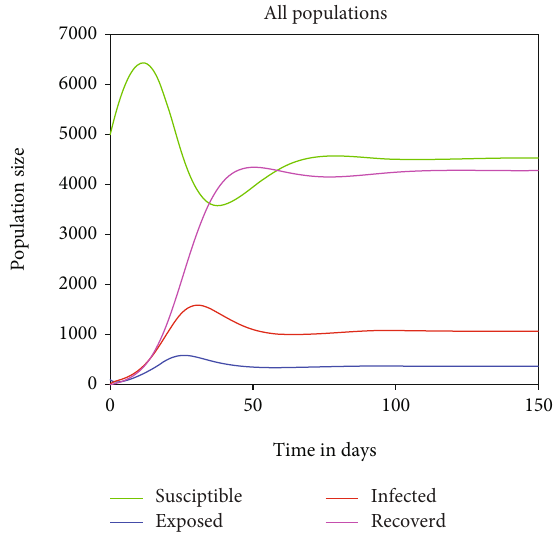
Figure 8: Solutions of the TB-19 model with parameter values Λ = 500 , β = 0 : 6 , μ = 0 : 0477 , γ = 0 : 16 , δ 1 0 : 09 , and its basic reproduction number is R T